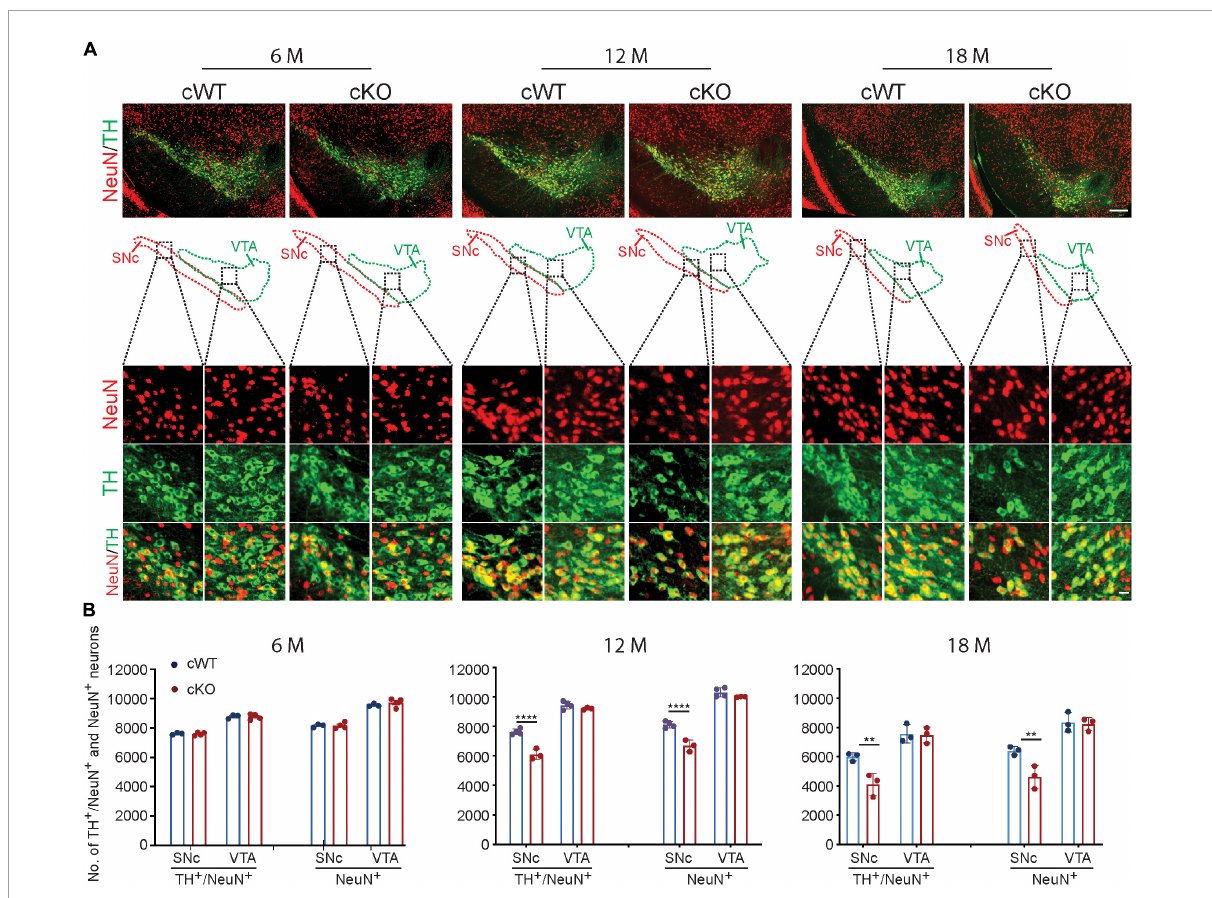
FIGURE1 Neurodegeneration in 12- and 18-month-old Pitx3 cKO mice. (A) IFC co-staining of TH and NeuN in the ventral midbrain sections from 6-, 12-, and 18-month-old Pitx3 cWT and Pitx3 cKO mice. SNc and VTA were outlined, respectively (scale bar: 200 µ m; high-magnification, 20 µ m). (B) Quantification of TH + /NeuN + and NeuN + neurons in the SNc and VTA from 6-, 12-, and 18-month-old Pitx3 cWT and Pitx3 cKO mice ( N = 3–4 mice per genotype; all males except for two females in 6-month-old Pitx3 cKO and 12-month-old Pitx3 cWT ). 2way ANOVA analysis with Sidak’s multiple comparisons test, **** p < 0.0001 (12 months for TH + /NeuN + co-staining), **** p < 0.0001 (12 months for NeuN + staining), ** p = 0.0041 (18 months for TH + /NeuN + co-staining), ** p = 0.0064 (18 months for NeuN +